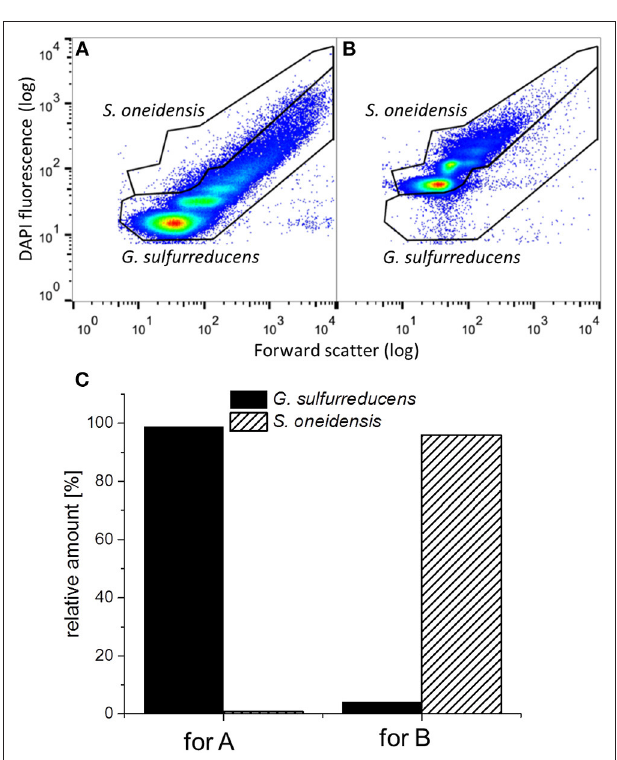
FIGURE 6 | Representative dot plots from (A) a G. sulfurreducens pure culture biofilm and (B) a planktonic S. oneidensis pure culture and (C) the thereof determined relative amount of cell counts in the G. sulfurreducens gate (filled) and the S. oneidensis gate (diagonally